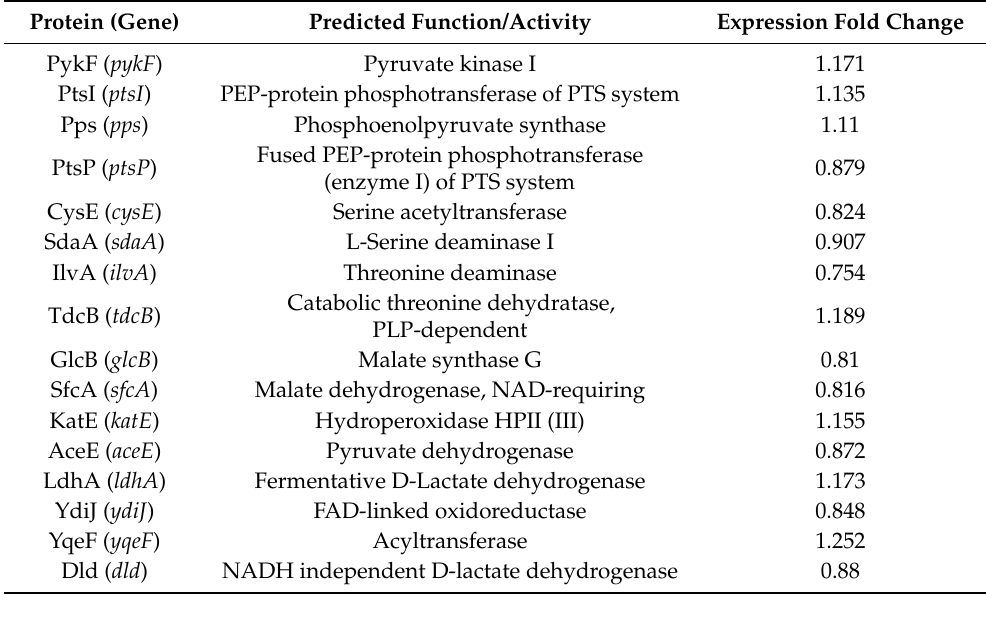
Table 1. Selected carbon metabolism-related proteins with significantly changed expression levels under Mn supplementation from the proteomics data of E. coli MB266.